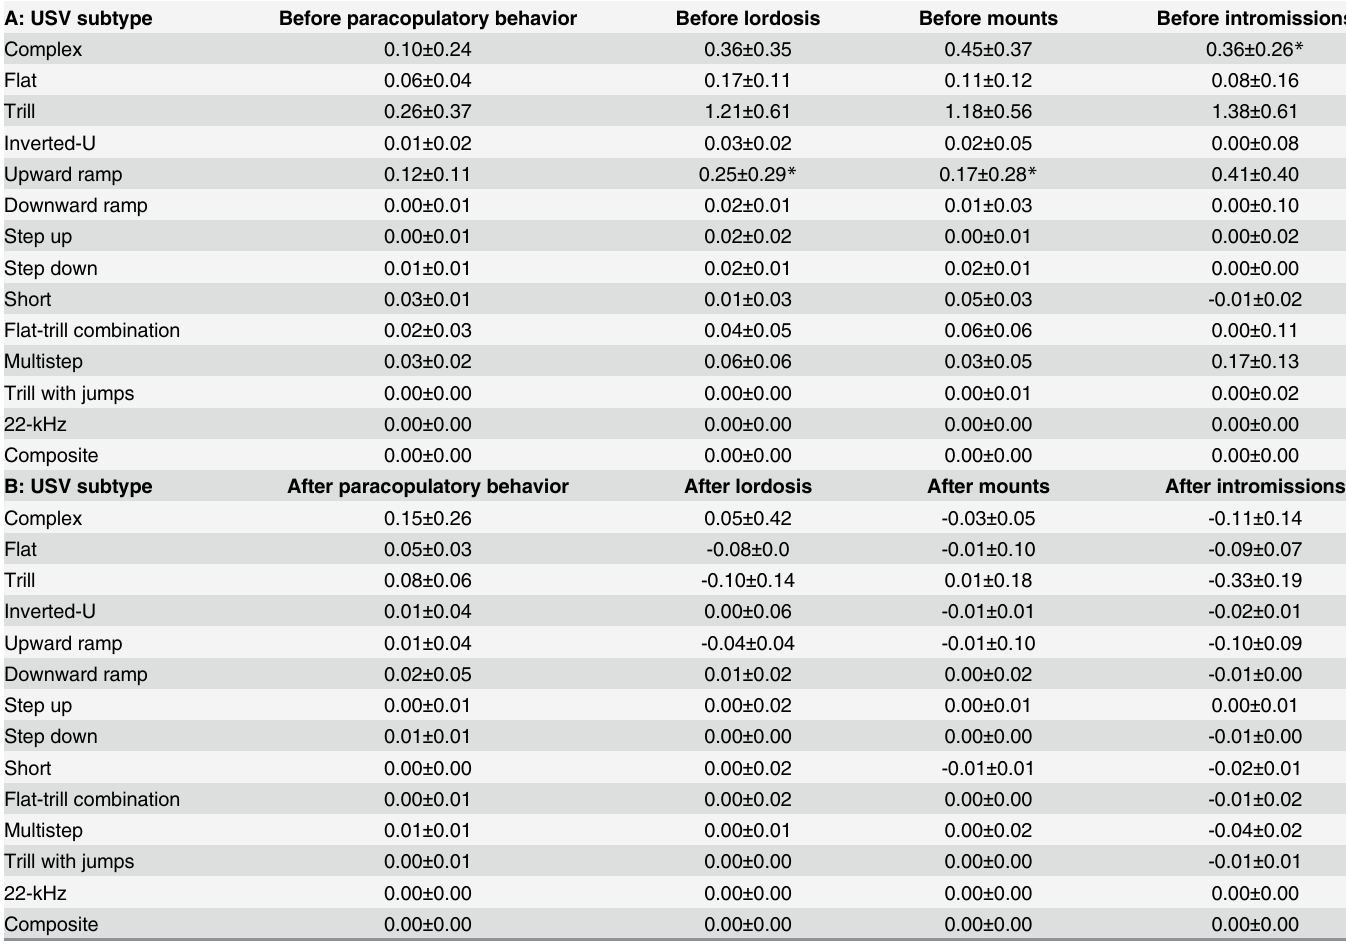
Table 1. Only a few changes in emission of male USV subtypes before and after a